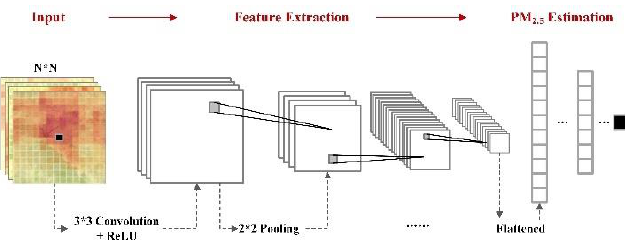
Figure 1. The structure of a CNN model for PM 2.5